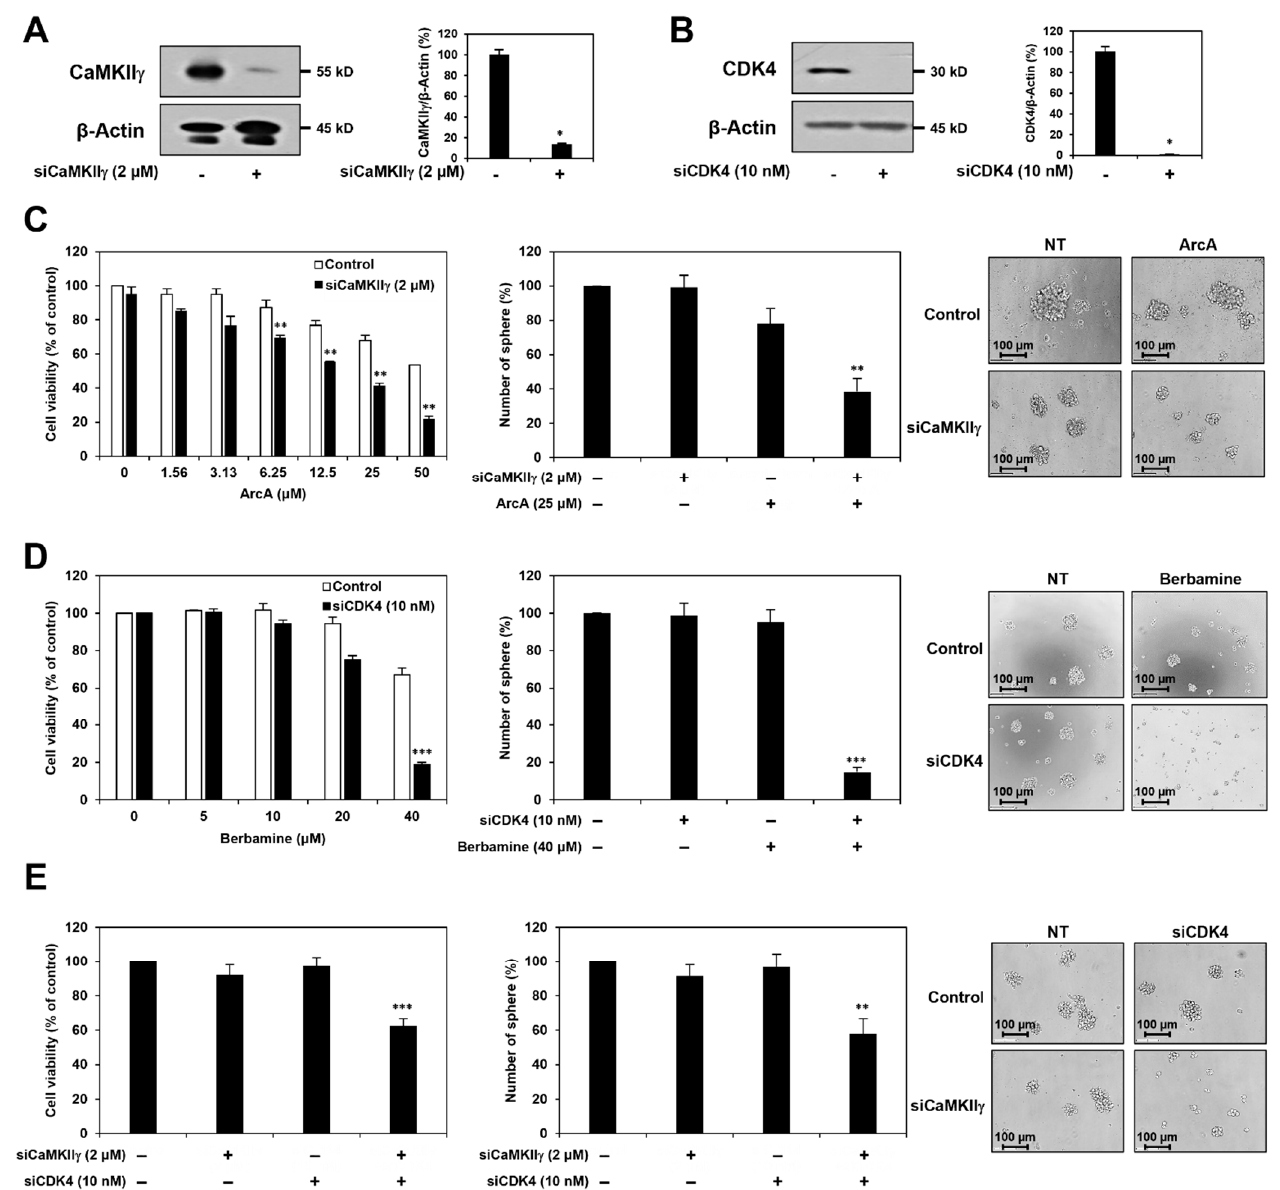
Figure 5. Synergistic anticancer effect of berbamine and ArcA on GSCs is related to dual inhibition of CaMKII γ and CDK4. U87MG cells were transfected with either CaMKII γ siRNA or CDK4 siRNA. Knockdown of ( A ) CaMKII γ and ( B ) CDK4 genes was confirmed by Western blot analysis. Protein levels were detected by Western blot analysis using specific antibodies and were further quantified by densitometry. β -Actin levels were used as an internal control. * p < 0.05 vs. the control siRNA. Following genetic knockdown, U87MG-derived GSCs were treated with the indicated concentrations of ( C ) ArcA and ( D ) berbamine for 7 days. ( E ) Effect of simultaneous knockdown of CaMKII γ and CDK4 genes on the cell viability and tumorsphere formation of U87MG-derived GSCs. ( C – E ) Cell viability was measured using the CellTiter-Glo ® luminescent assay system. The number of formed tumorspheres was counted under an optical microscope. ** p < 0.01, *** p < 0.001 vs. the compound alone or the single gene